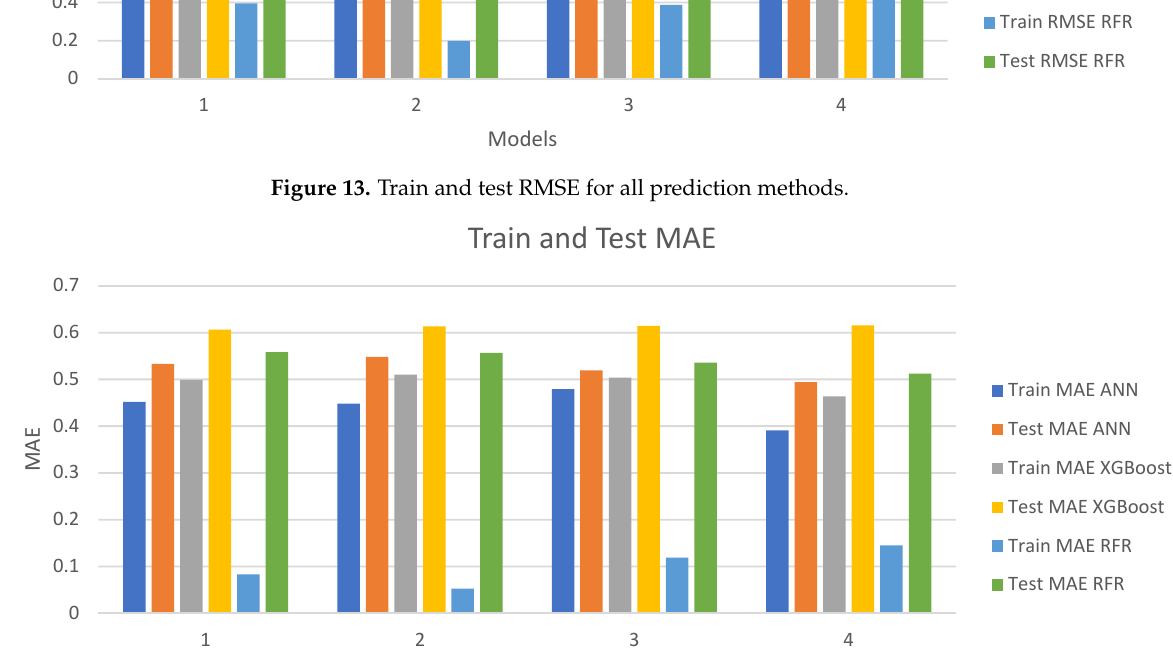
Figure 14. Train and test MAE for all prediction methods.